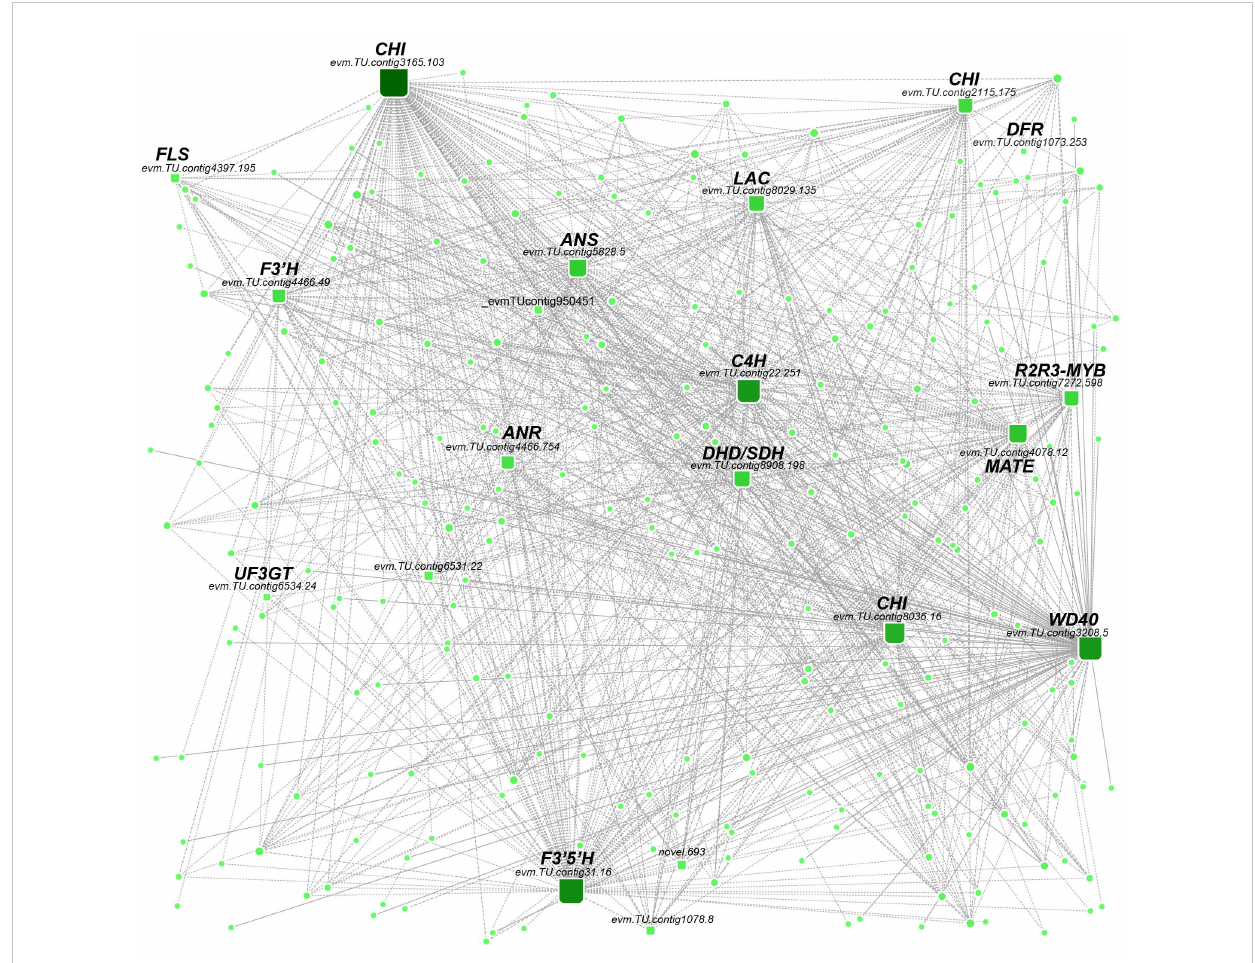
FIGURE 4 Weighted gene coexpression network analysis. The linkages between TFs and fl avonoid-related structural genes in the MEblue module and the sizes of round rectangles were changed according to gene